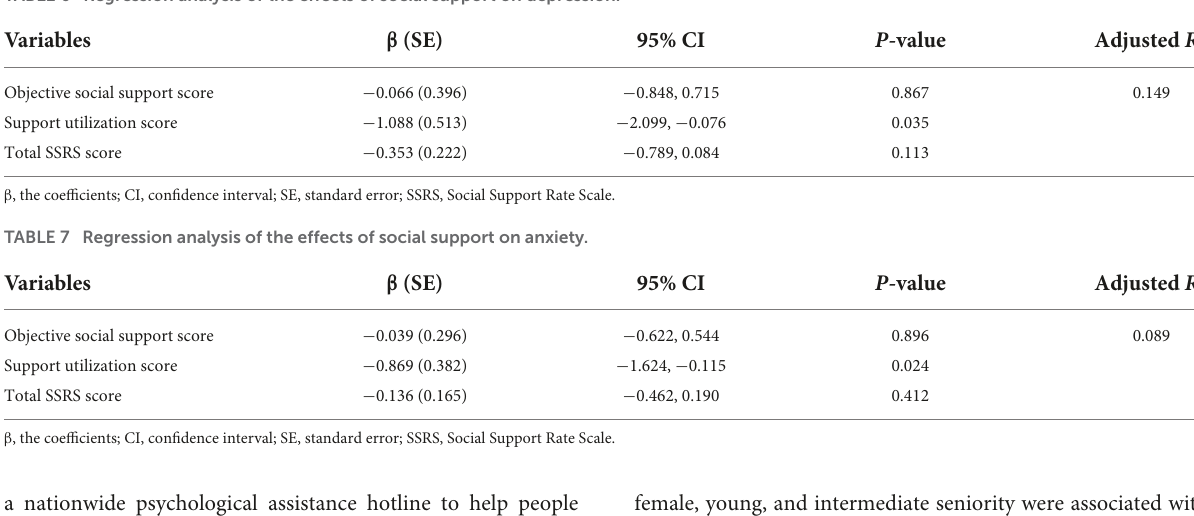
TABLE 6 Regression analysis of the effects of social support on depression.